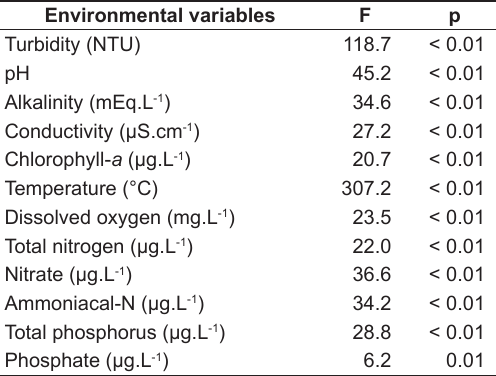
Table 2. The ANOVA results of the environmental variables in the studied